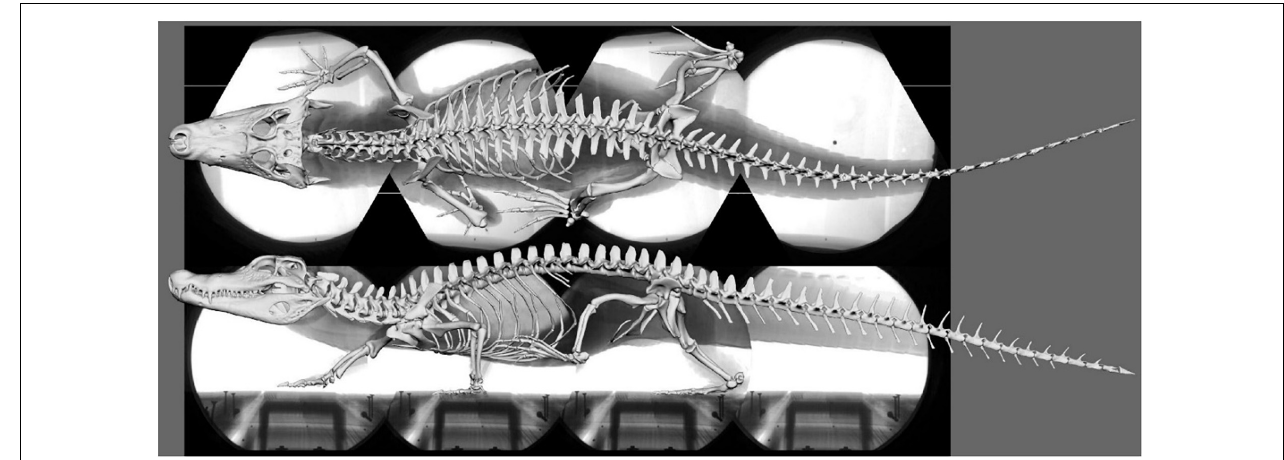
FIGURE 1 | Superimposed skeleton on the X-ray video collage in dorsal (top) and lateral (bottom) view ( Supplementary Video 1 ).